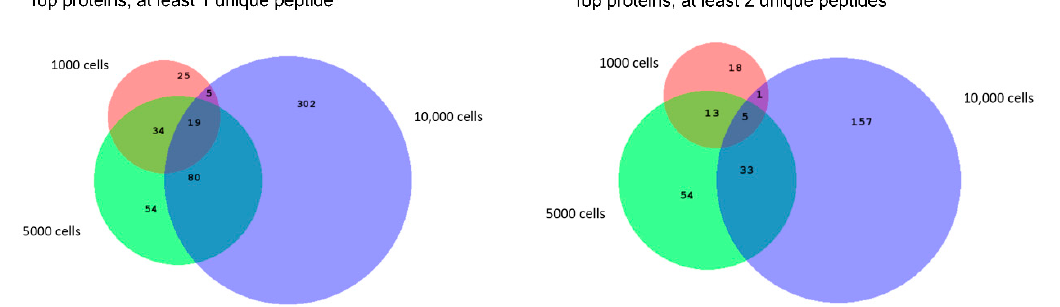
Figure 5. Qualitative proteomic analysis of different amounts of FACS sorted cells. Venn-diagram representing an overlap in the number of top proteins identified between 1000, 5000, and 10,000 cells when either at least one unique peptide per protein is taken into account (left) or when at least two unique peptides per protein are taken into account (right).